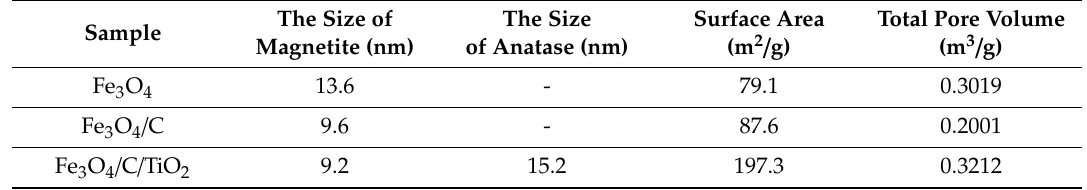
Table 1. Average crystallite size, surface area, and total pore volume of obtained nanostructures.